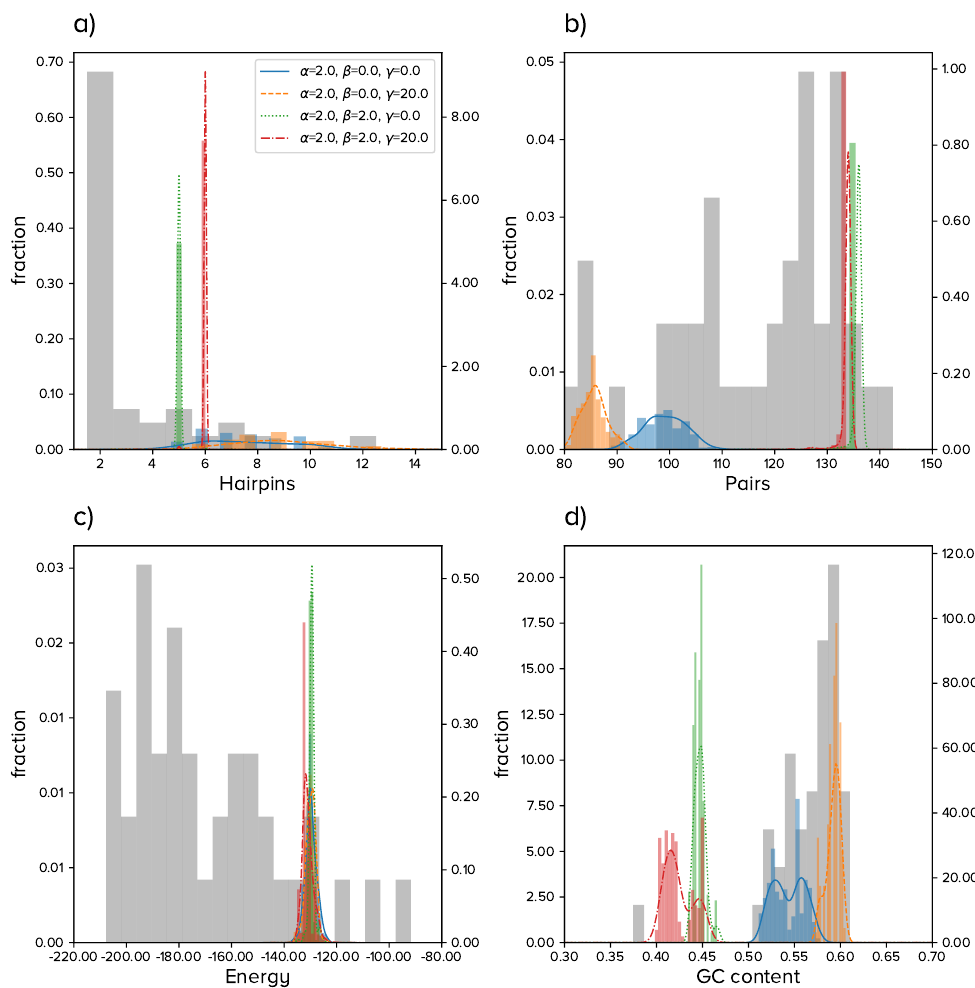
Figure 1. Summary of the results for the evolution of populations of circular RNA sequences of fixed length. Histograms in color correspond to numerical simulations with parameters specified in the legend. Lines are kernel density estimates of the underlying distribution. Grey bars correspond to viroids in Table 1. ( a ) Number of hairpins h ; ( b ) number of base pairs p ; ( c ) minimum free energy of the secondary structure; ( d ) G + C